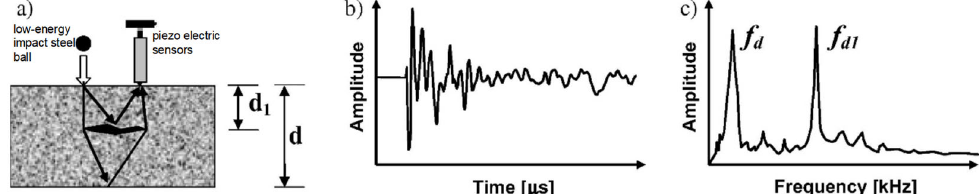
Figure 9. A nondestructive impact–echo technique to evaluate the interface quality in a repaired system: ( a ) Scheme of the impact–echo method; ( b ) example of waveform (time-domain spectrum); ( c ) corresponding frequency when defect in concrete is observed [57]. (Adapted and reprinted with permission from ref. 57, © 2017, Construction and Building Materials .).